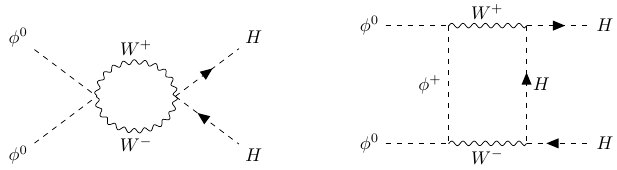
Figure 1: Two representative diagrams contributing to λ at one